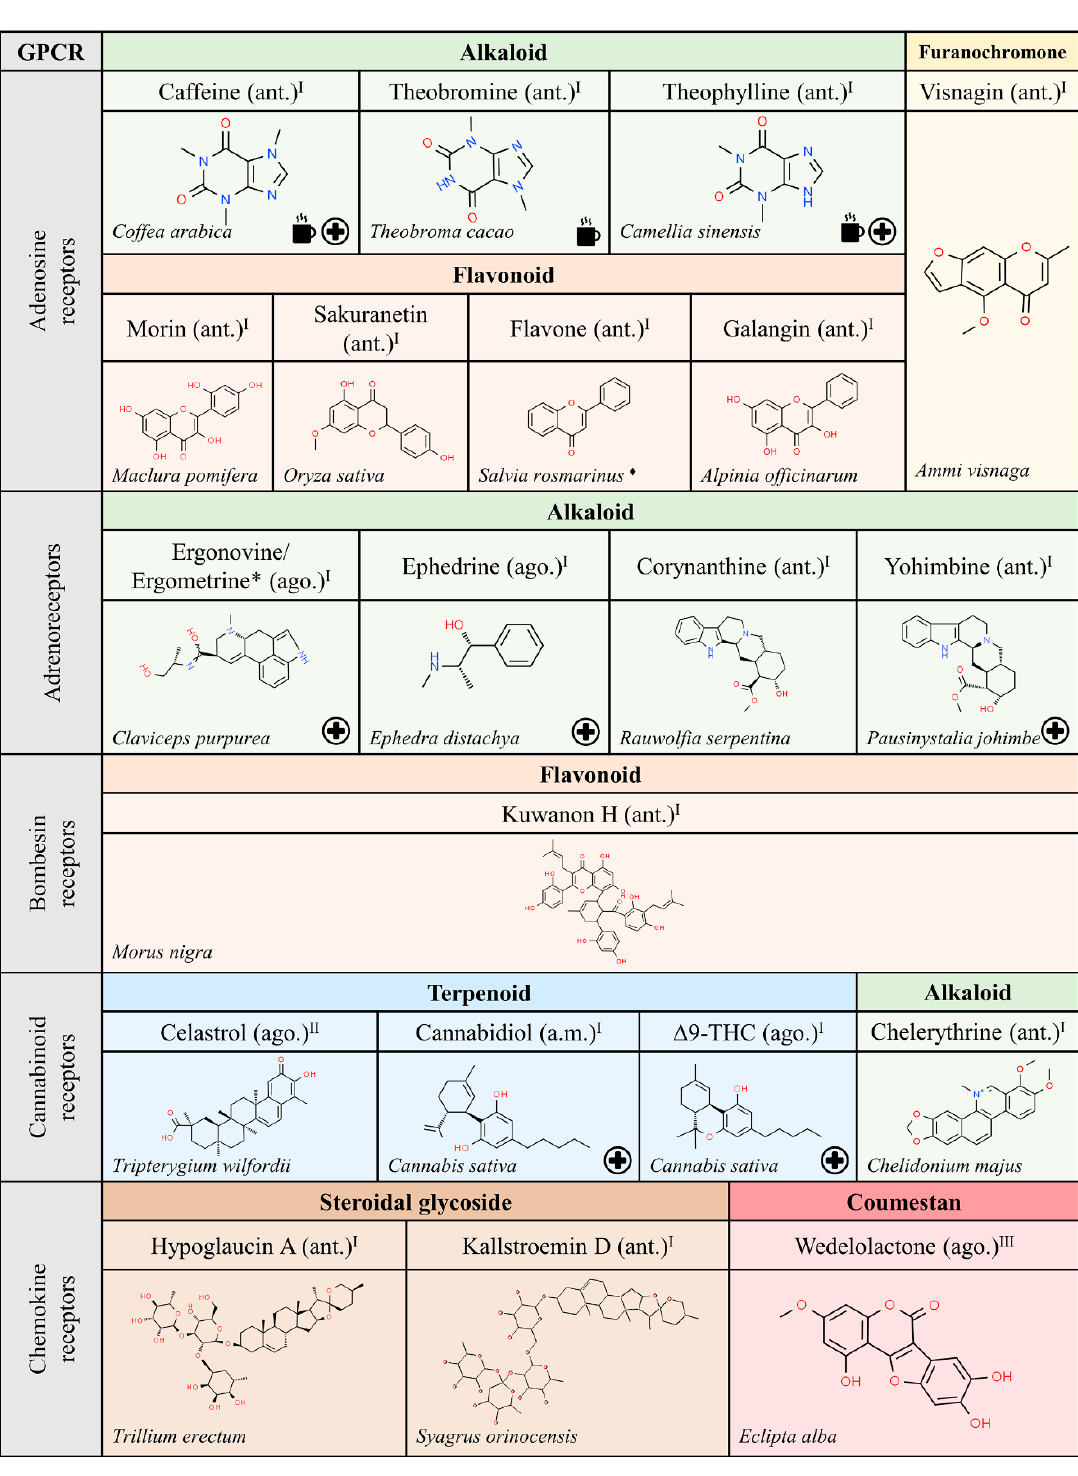
Figure 3. Natural ligands of GPCRs from plants (part. 1). Each chemical class is highlighted with different colors. The chemical structures were found on ChemSpider website. Legend: the plus symbol means that the compound is approved by the Food and Drug Administration. The cup icon means that the compound is a methylxanthine (present in tea/coffee/cacao). The asterisk (*) means that the molecules are isomers. The rhomboid ( ♦ ) means that there are several examples of organisms. Ago.: agonist; ant.: antagonist; a.m.: allosteric modulator. Superscript: (I) [1]; (II) [32]; (III) [16].